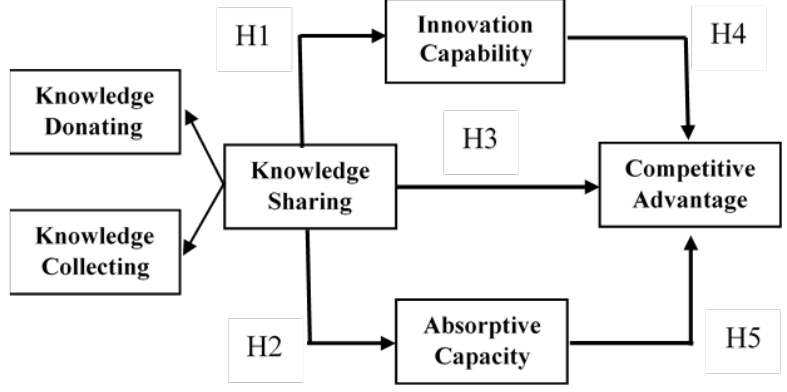
Figure 1: Research Model (Lo & Tian, 2020; Kurniawan et al.